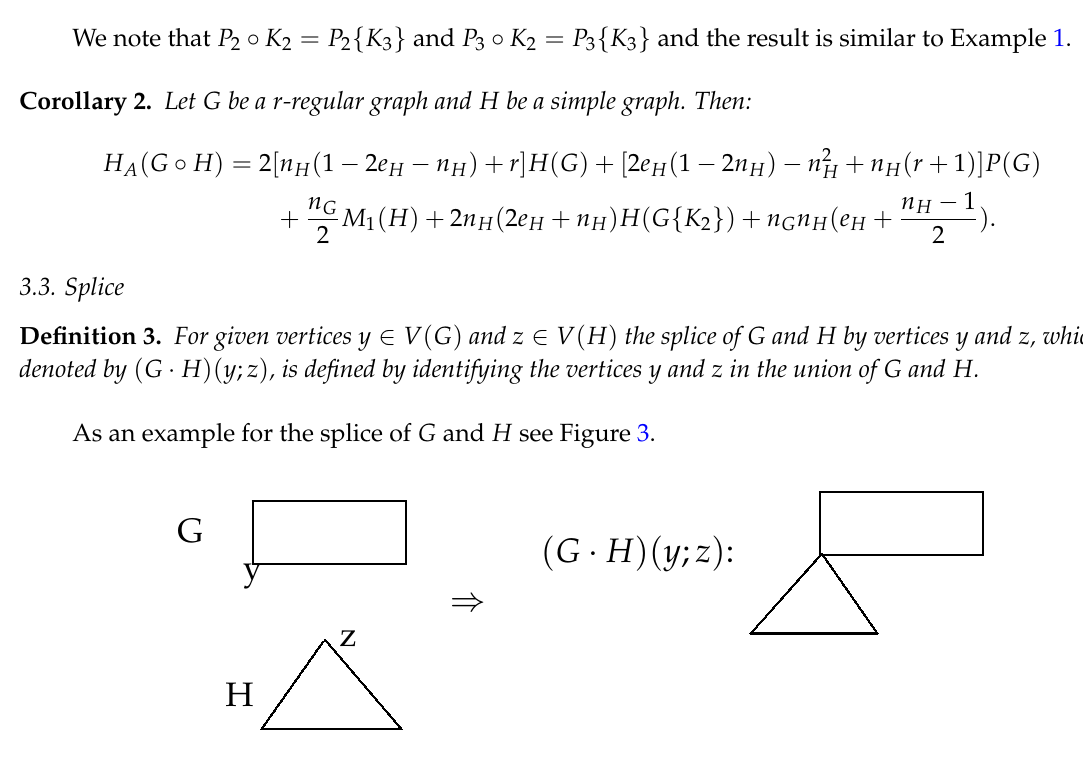
Figure 3. The splice of G and H by vertices y and z